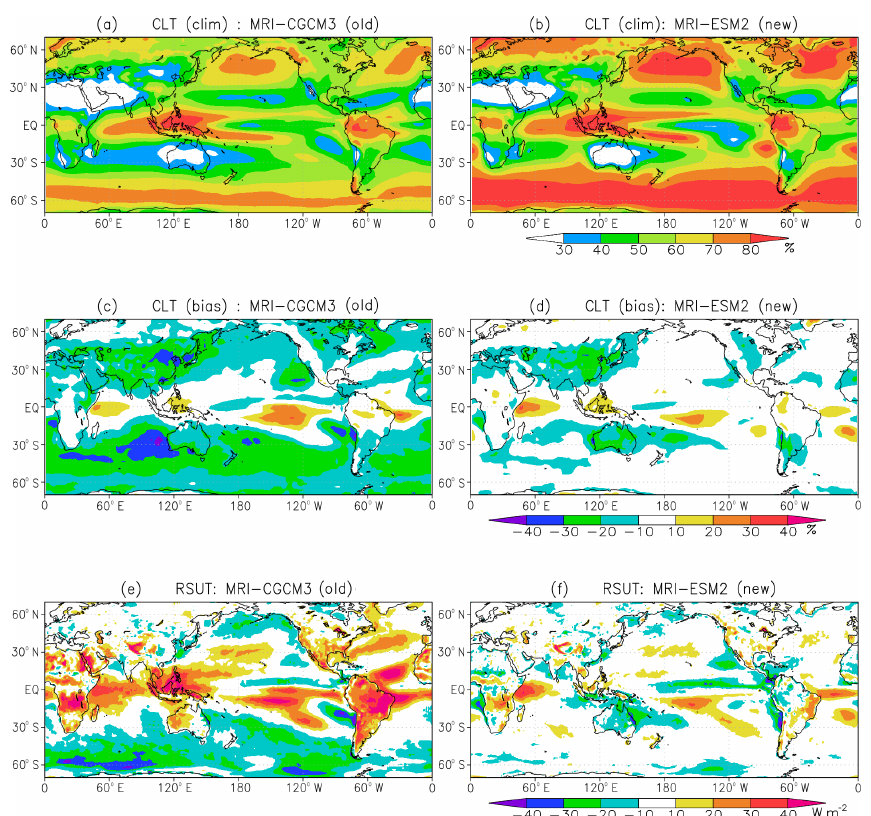
Figure 1. (a, b) Climatologies of total cloud cover (%), (c, d) biases of total cloud cover (%) with respect to ISCCP observations and (e, f) bi- ases of upward shortwave radiative flux (Wm − 2 ) at the top of the atmosphere with respect to CERES-EBAF simulated by (a, c, e) MRI- CGCM3 and (b, d, f) MRI-ESM2. The climatologies cover the period 1986–2005 for model simulations and ISCCP observational data and 2001–2010 for CERES-EBAF data.